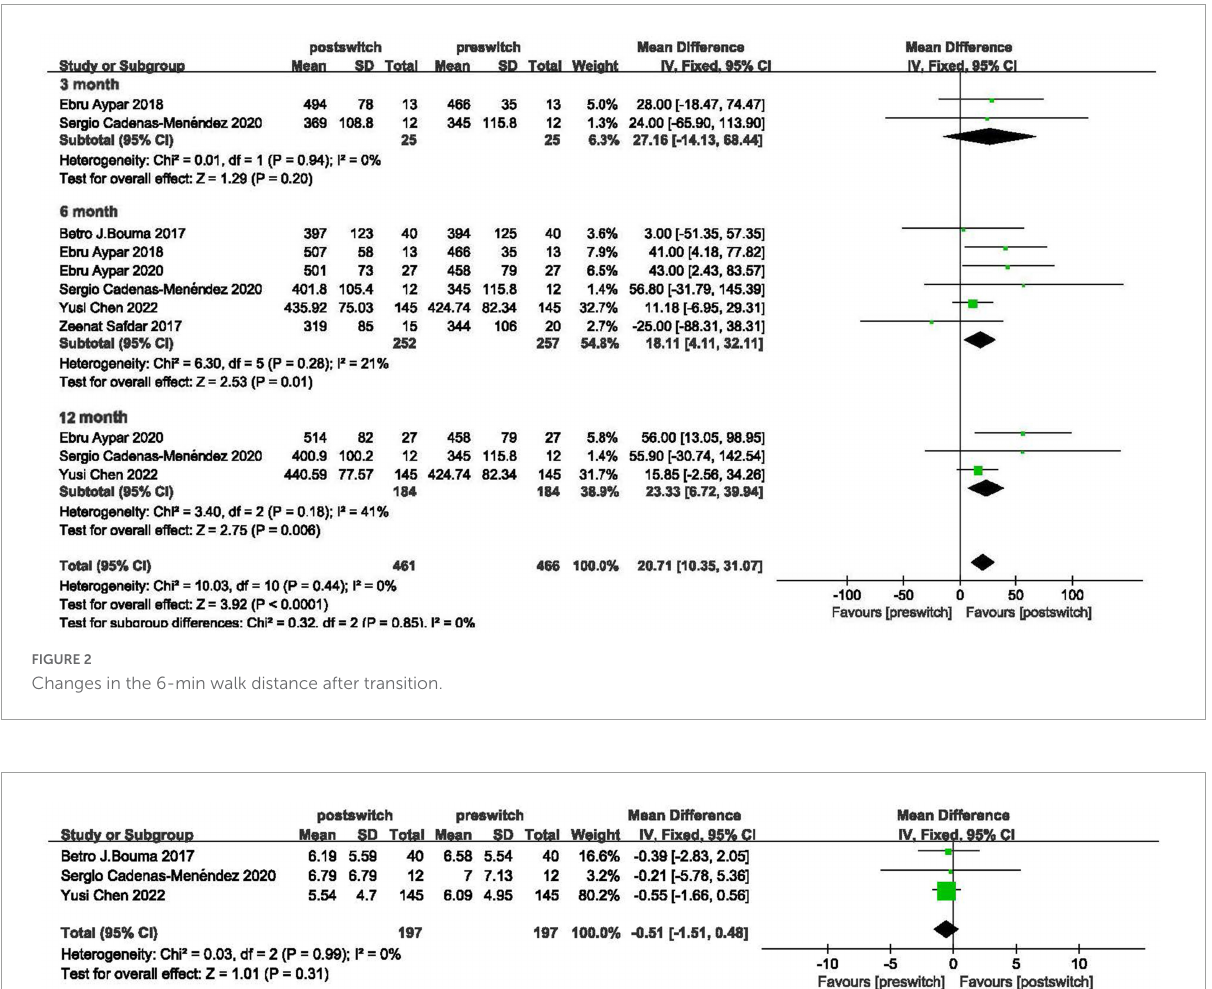
FIGURE3 Changes in N-terminal pro-brain-type natriuretic peptide levels after transition.